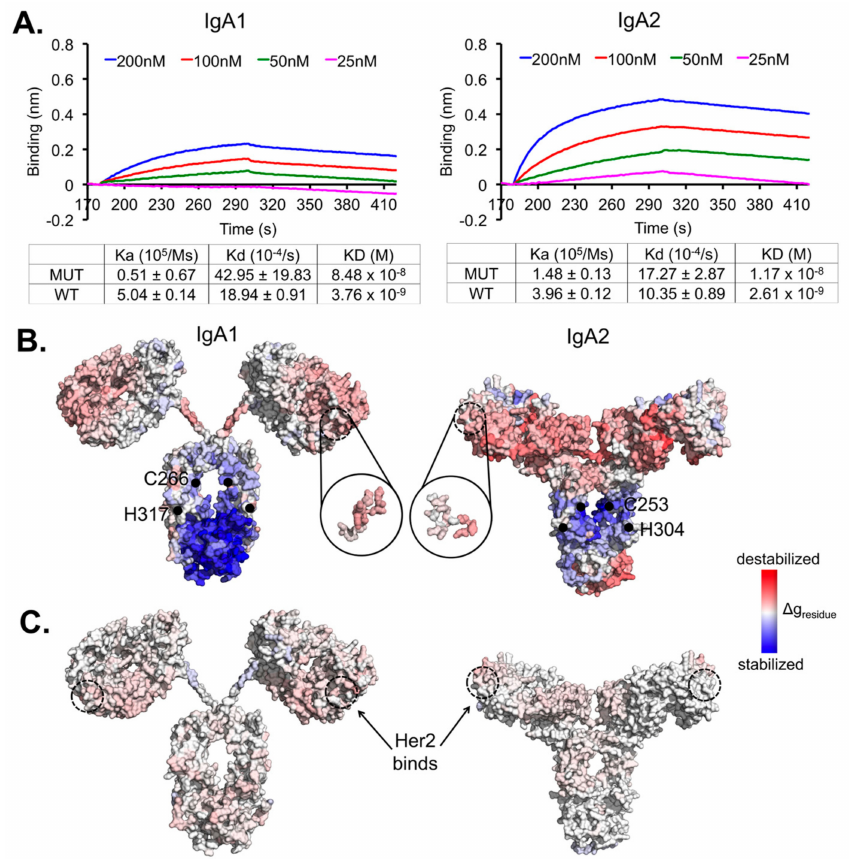
Figure 1. Synergistic allosteric effects by the two IgA1 and IgA2 constant region mutations on the Her2-binding variable regions. ( A ) Binding kinetics analysis of the isotype variants IgA1 and IgA2 to Her2, using the antibodies at 200 nM to 25 nM to pre-loaded Her2 on NTA biosensors. The binding kinetics was measured using Blitz ® . All experiments were performed in triplicates independently. The binding kinetics values of the wild-type IgA1 and IgA2 shown were obtained from our previous work [25]. ( B ) Surface presentations of the quantified allosteric communications (presented by residual allosteric free energy change ∆ g residue ) demonstrate destabilizing effects on the Her2 binding region caused by the mutations (black dots) in both the mutant constant region variants. ( C ) The quantified allosteric effects shown were based on the event of Her2 bindings. In ( B , C ), the effects were estimated using the minimized structures of both the wild-type IgA subtypes for perturbations with respect to mutating or binding